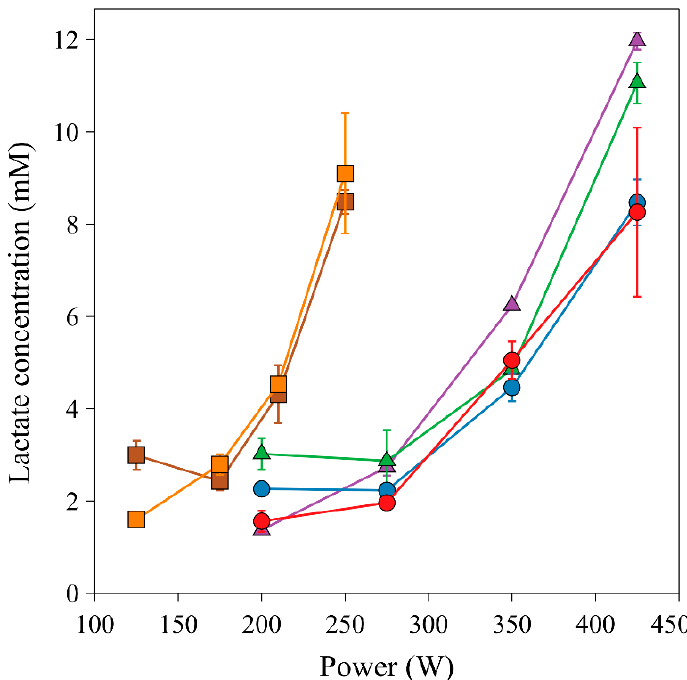
Figure 3. Graph of lactate concentration in blood plasma at 4 different power settings. Separation conditions: BGE 10 mM HIS, 15 mM GLU, pH 4.6, injection: hydrodynamic, 30 s/10 cm, separation voltage − 18 kV, separation current 6.1 µA. ( (cid:3) -untrained cyclist, (cid:52) , -trained cyclists, different color is for values measured on different days).